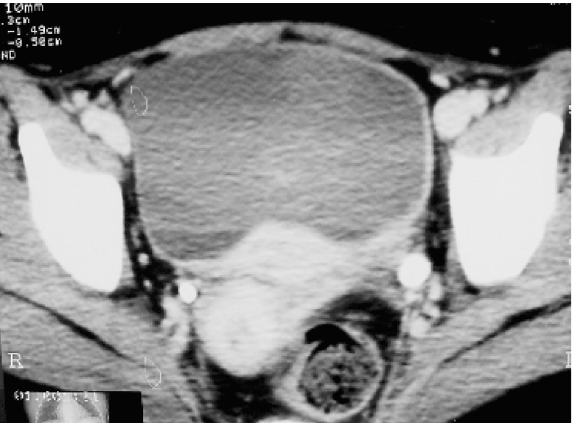
Figure 1 – Computerized abdominal tomography showing a pel- vic mass with indefinite limits between the uterus and bladder, causing a bulging in the trigone